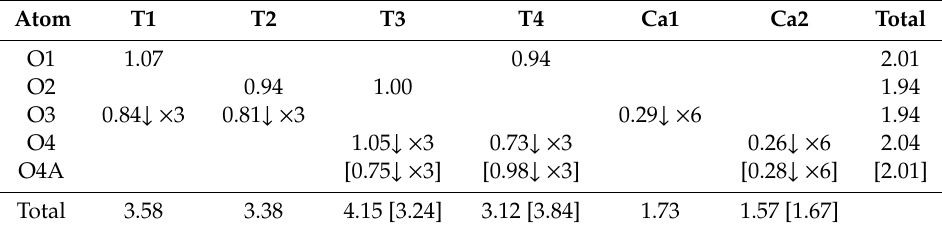
Table 4. Bond-valence sums analysis (v.u. = valence units) for dmisteinbergite *.